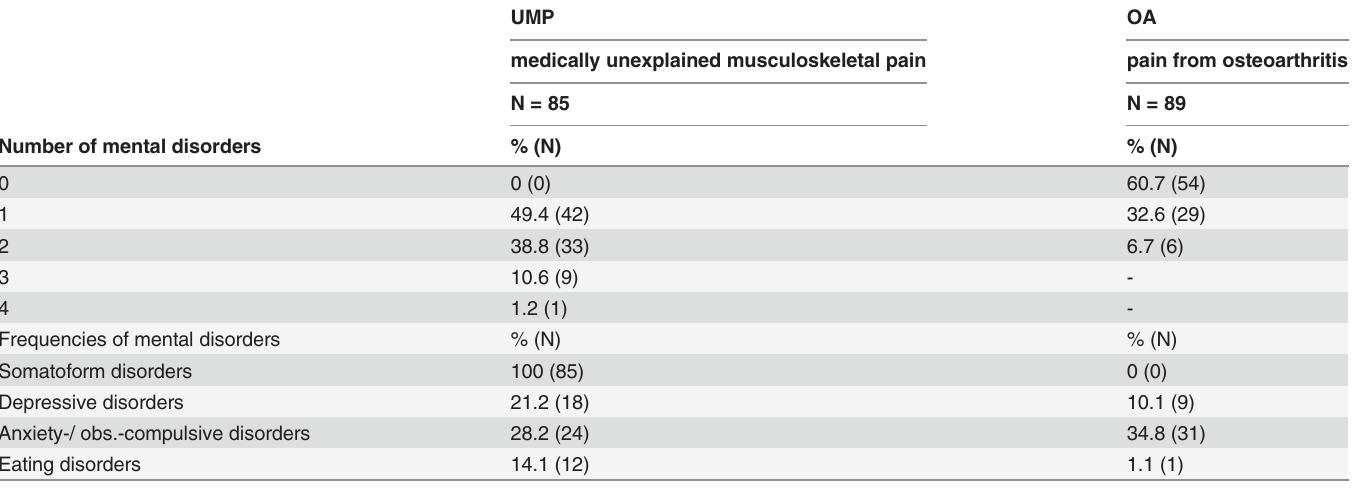
Table 2. Number and frequencies of SCID-I-Diagnoses according to